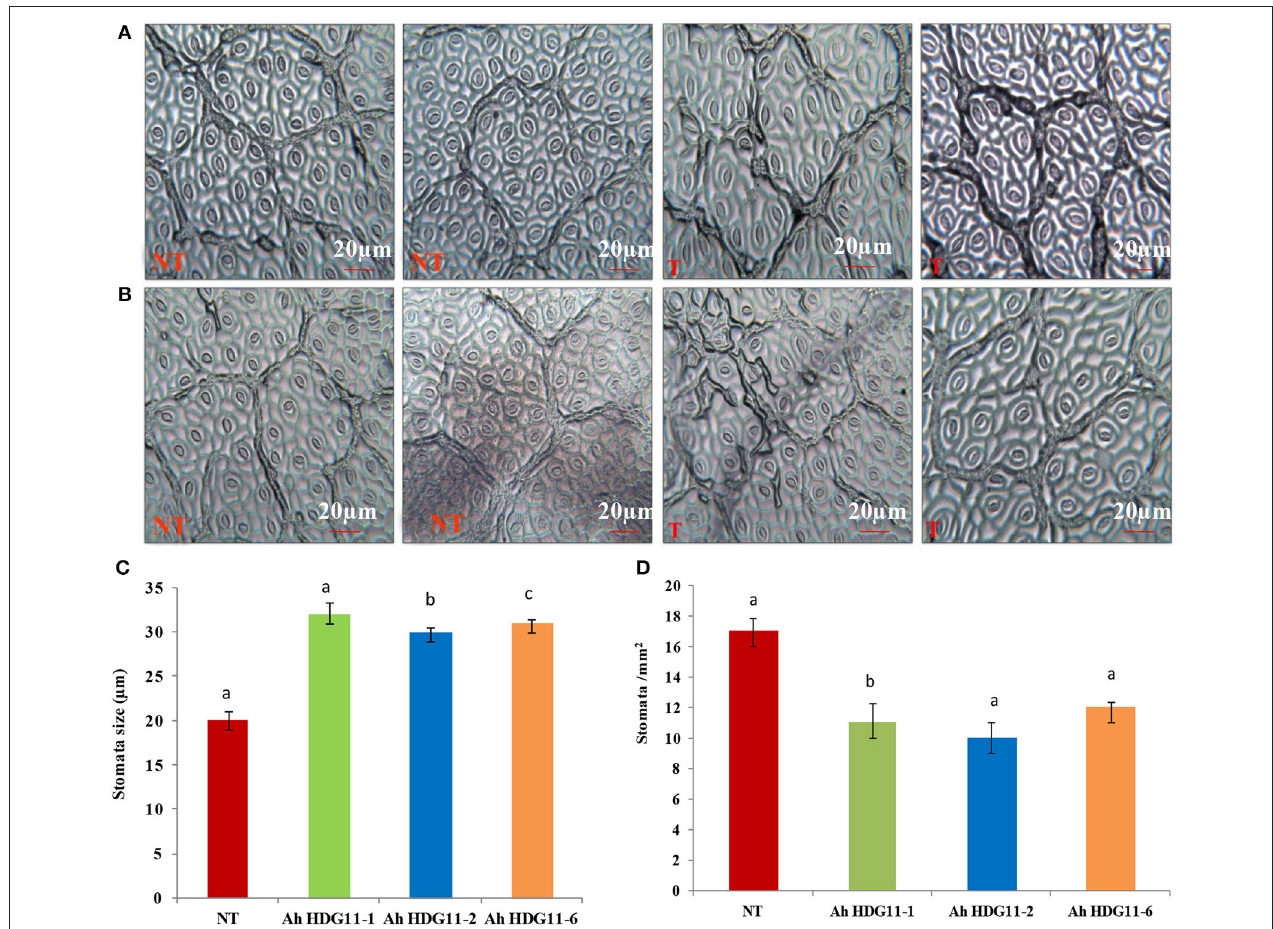
FIGURE 5 | Stomatal analysis of three transgenic lines AhHDG11-1, AhHDG11-2, AhHDG11-6 along with the control untransformed parent JL-24 (NT) under control (well-watered), drought, and salt stress from the confined outdoor lysimetric experiment. Adaxial epidermal imprint image of (A) Drought stressed plants. (B) Salt stressed plants. (C) Stomatal width ( µ m). (D) Stomatal density (Stomata/mm 2